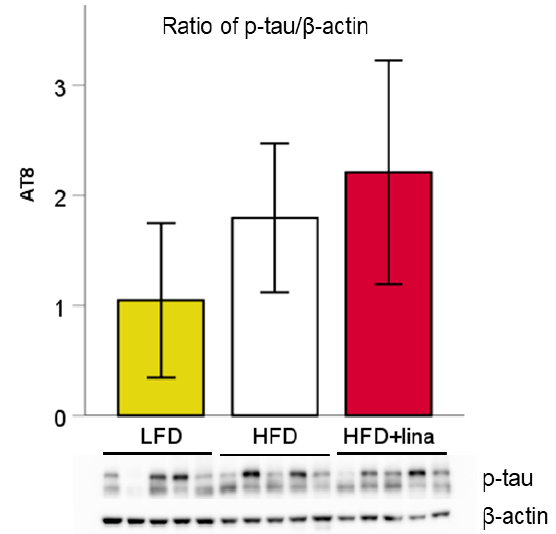
Figure 5. Effects of linagliptin (10 mg/kg BW/day) on tau phosphorylation in PS19 mice at 8 months of age. Representative Western blot for ratio of phosphorylated tau (p-tau)/β-actin. Values are presented as the mean ± SD ( n = 5 for each group).